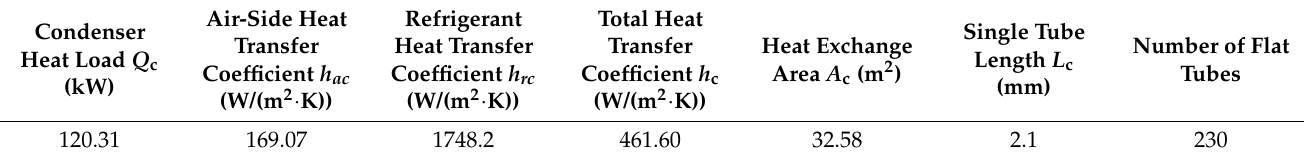
Table 6. The results for the condenser